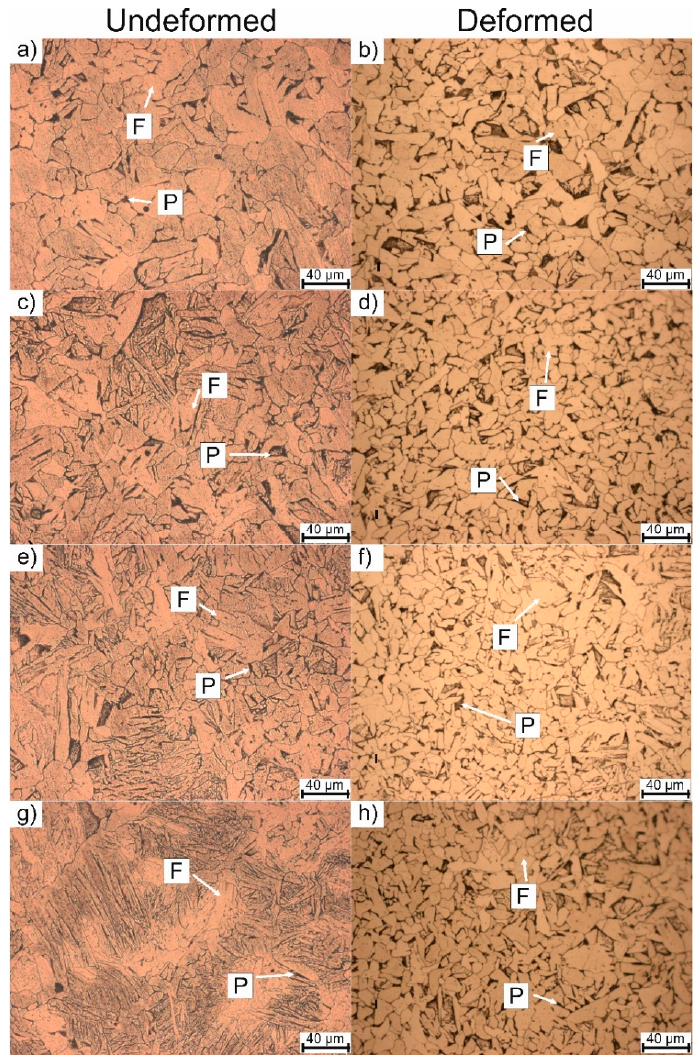
Figure 7. Microstructures of non-deformed and deformed samples at different cooling rates: ( a , b ): 8 °C/s, ( c , d ): 15 °C/s, ( e , f ): 25 °C/s, ( g , h ): 50 °C/s. ( c , d ): 15 ◦ C / s, ( e , f ): 25 ◦ C / s, ( g , h ): 50 ◦ C /